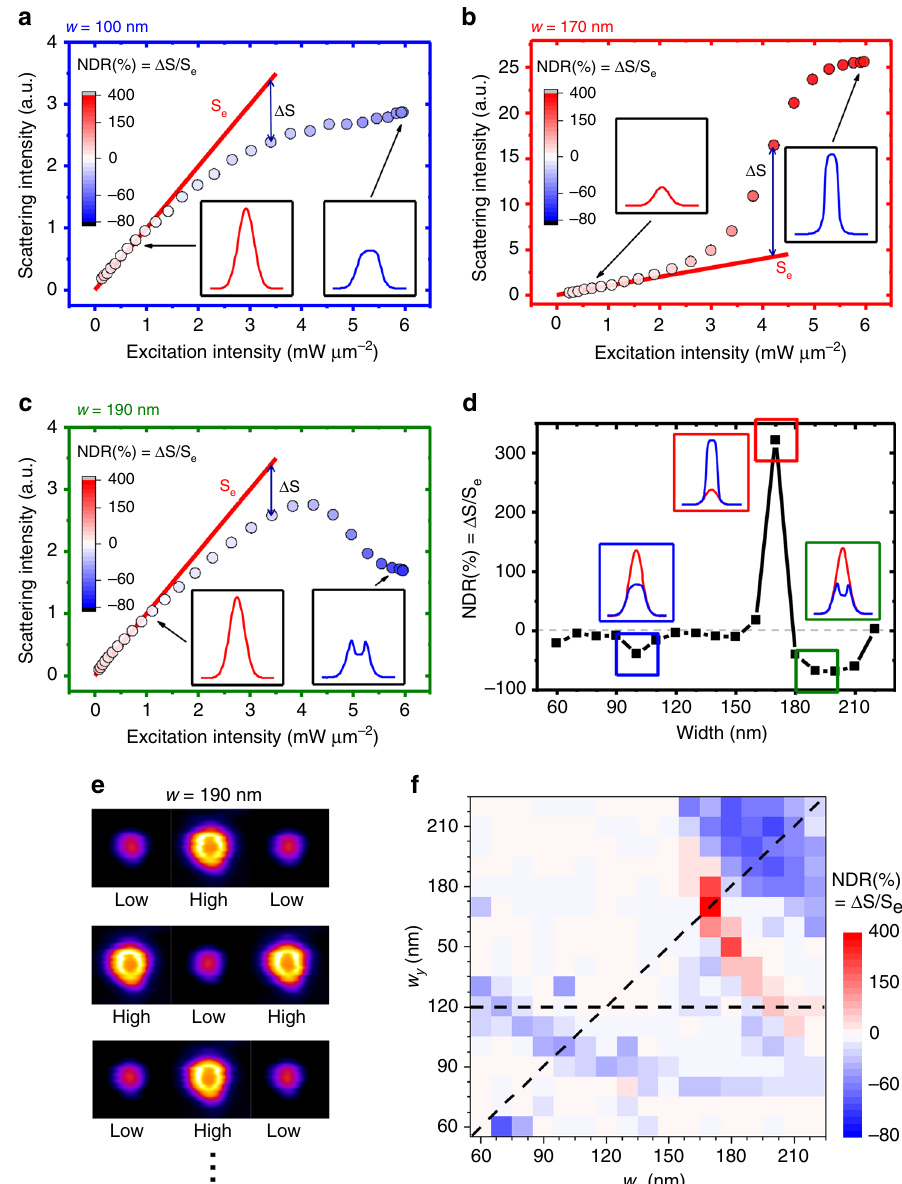
Fig. 2 Experimental observation of nonlinear scattering. a – c Excitation intensity-dependent scattering for w ¼ 100nm ; 170nm ; 190nm, observed using a dark- fi eld laser-scanning microscope at λ = 561 nm. In the main frames, red lines and colored dots indicate linear scattering intensity (S e , extrapolated from low-intensity excitation, see Supplementary Figs. 4 and 5) and measured scattering intensity (whose deviation from S e is Δ S ), respectively. An unexpectedly large nonlinearity is manifested through the signi fi cant deviation from linear intensity dependence. The color of the dots represents nonlinear deviation ratio (NDR), i.e., percentage of Δ S/S e . The insets correspond to PSFs at low and high intensities (lateral distance: 4 μ m). d NDR versus different sizes of nanoblocks at a 6 mW μ m − 2 excitation intensity. The dotted line marks 100%, which means no nonlinear response. The blue, red, and green rectangles highlight the regions of large NDR. The insets present the corresponding PSF pro fi les at low excitation (red curves) and high excitation (blue curves) intensities, where the large nonlinearity is again manifested by the large deviation of blue pro fi les from Gaussian distribution. e The PSF recovery during repetitive switching between low-intensity (1.3 mW μ m − 2 ) and high-intensity (6 mW μ m − 2 ) excitations, demonstrating reversible and repeatable nonlinear responses (see Supplementary Fig. 6 for other nanoblocks). f Experimental NDR map of the whole array. The diagonal dashed line marks the nanoblocks for analysis in Fig. 1d and Fig. 2. The horizontal dashed line marks non-diagonal nanoblocks that are compared to simulation in Supplementary Fig.